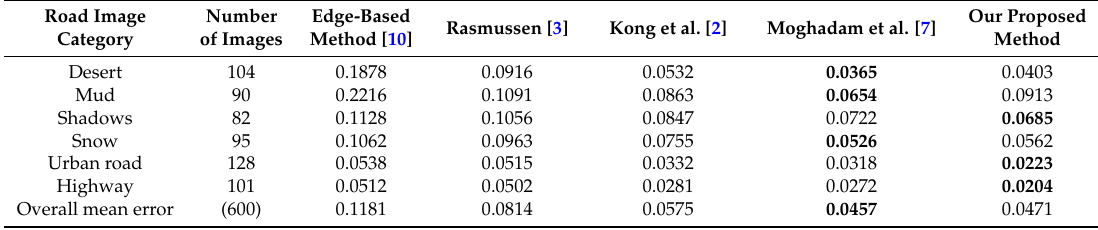
Figure 6. Comparison of vanishing point detection methods in the histogram. Table 2. Accuracy comparison for vanishing point detection.